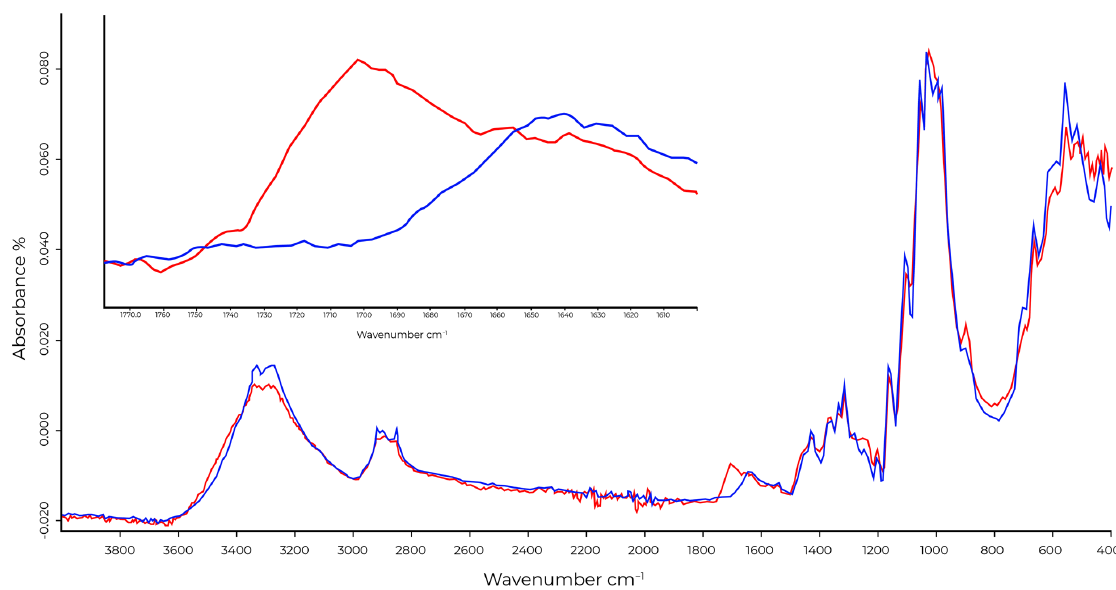
Figure 2. Full FTIR spectra of a pre-consumer cotton sample (blue) compared to a post-consumer cotton sample (red) with changes caused by dialdehyde formation on the cellulose by oxidation; enlarged FTIR spectra of a pre-consumer cotton sample (blue) compared to a post-consumer cotton sample (red) with changes caused by dialdehyde formation on the cellulose by oxidation: a change in the area of 1700–1730 cm − 1